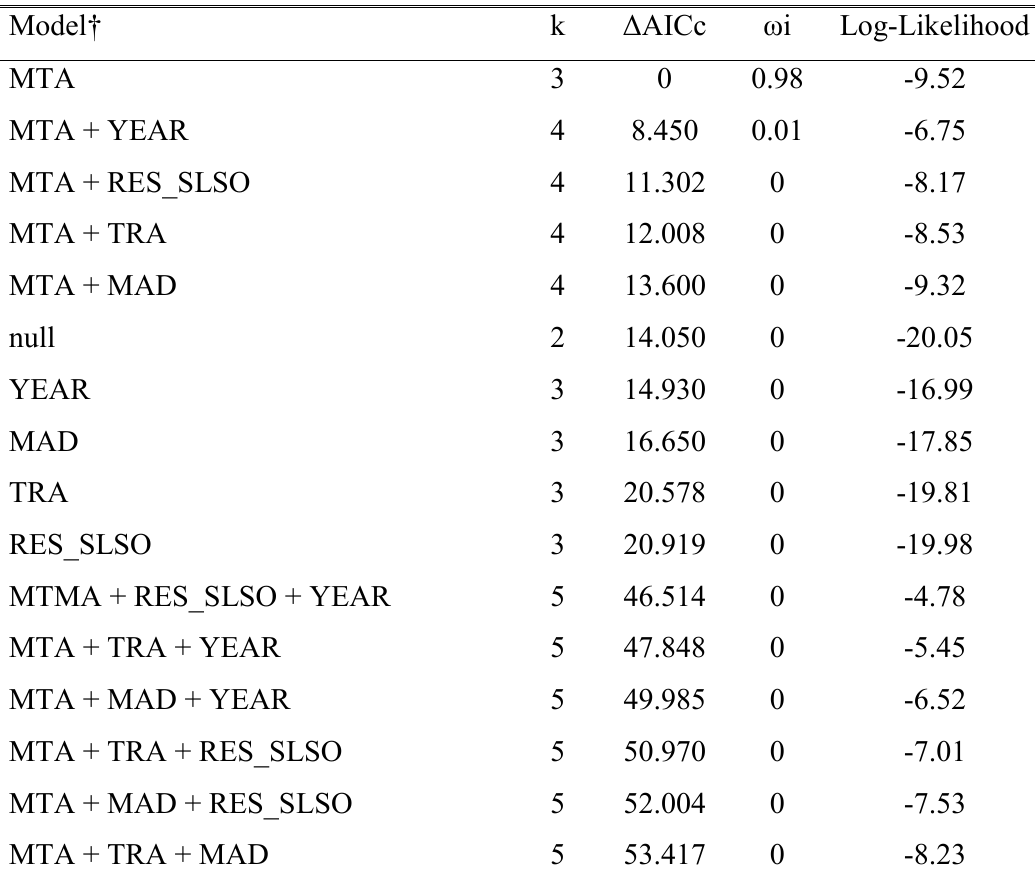
Table A1.2. Ranking of models explaining variation in the median laying date of Ring- billed Gulls at Ile de la Couvée (1978, 2000), Petite Colonie (1979), and Île Deslauriers